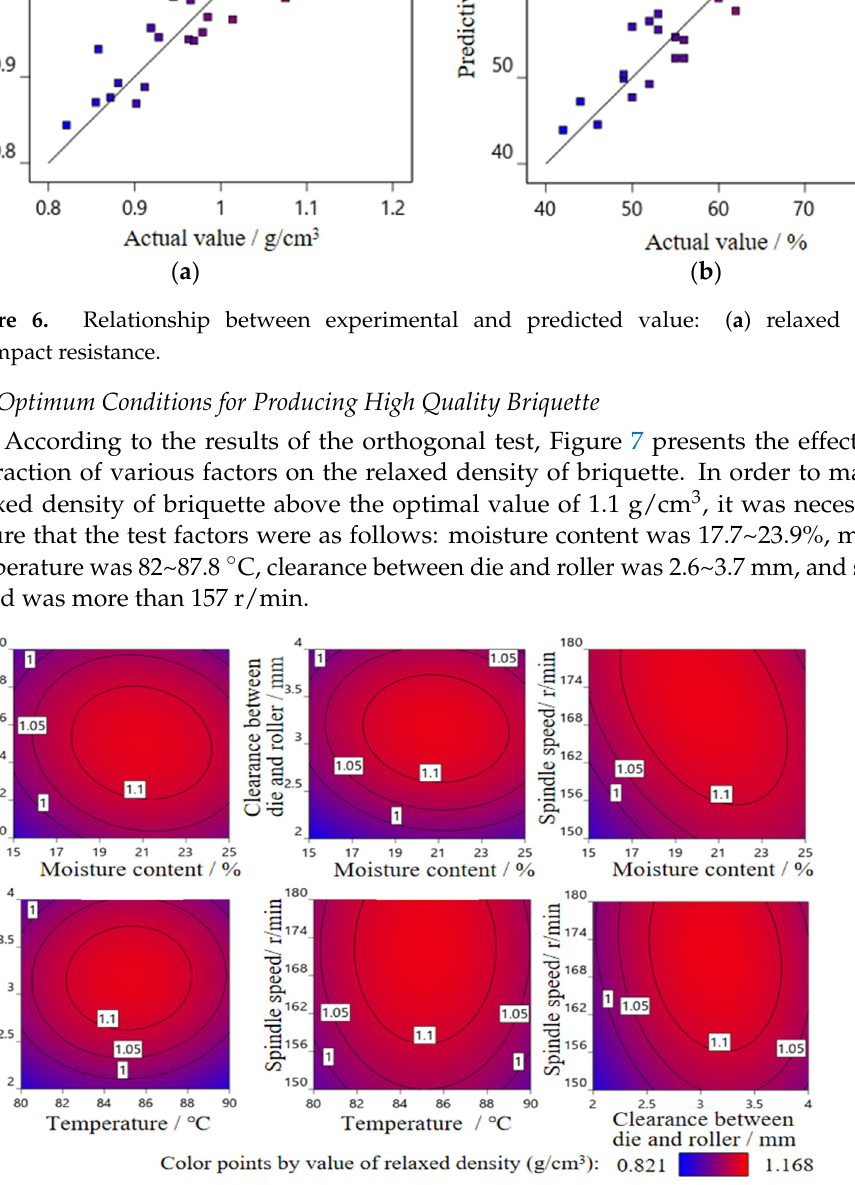
Figure 8. Contour sheet of impact resistance. Through the optimization function in the Design–Expert software, the optimal vari- able parameters were solved under the condition of the maximum relaxed density and impact resistance as displayed in Figure 9.